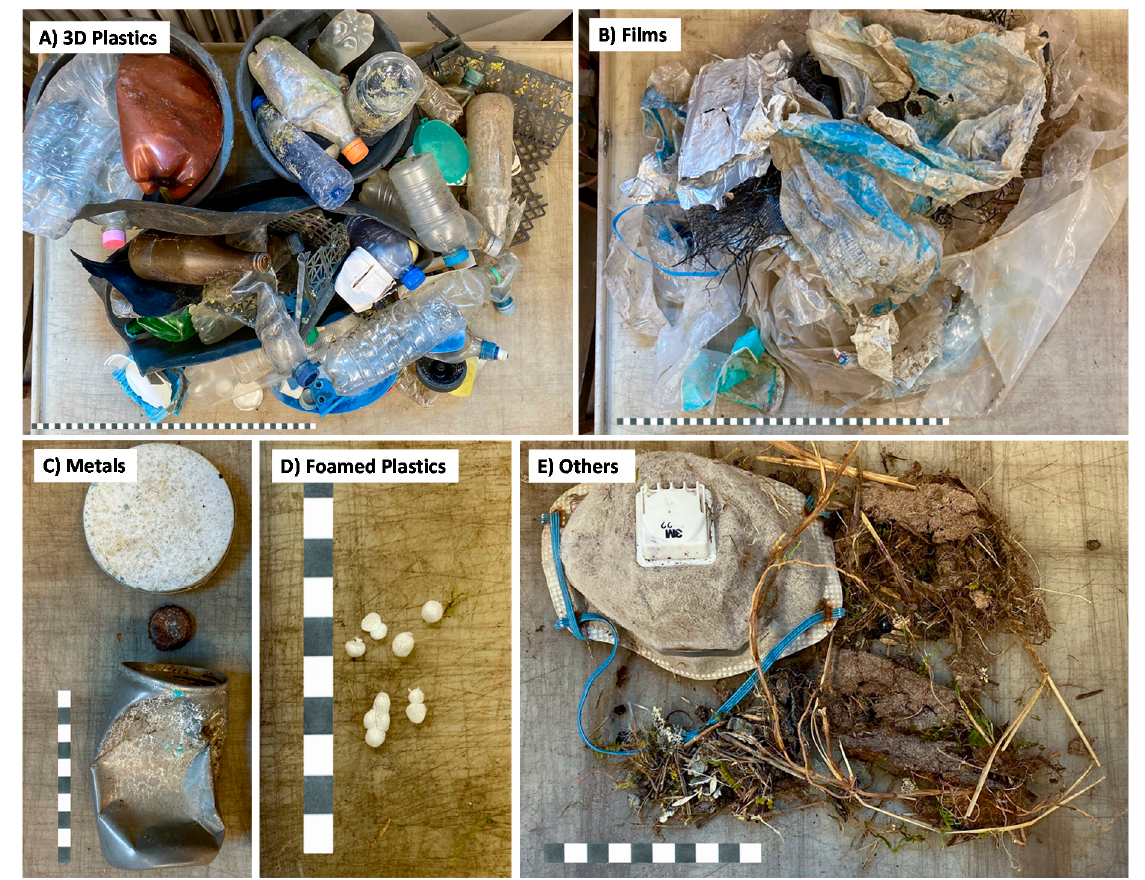
Figure 4. ML fractions Norderney: ( A ) 3D Plastics; ( B ) Films; ( C ) Metals; ( D ) Foamed Plastics and ( E ) Others. The scale amounts to 1 cm per section (Picture: Jacqueline Plaster, Johann Hee).